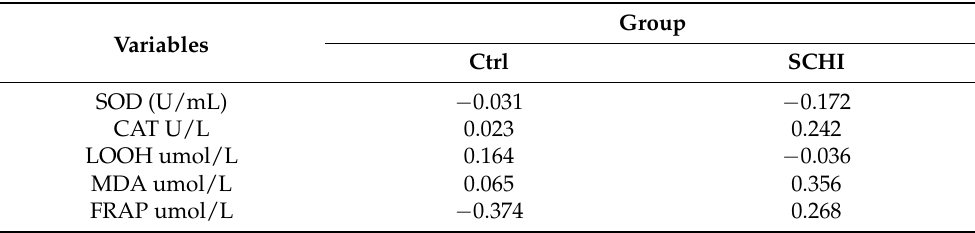
Table 4. The results of the analysis of the correlation between the CRP and the oxidative stress variables (both in SCHI and control group).